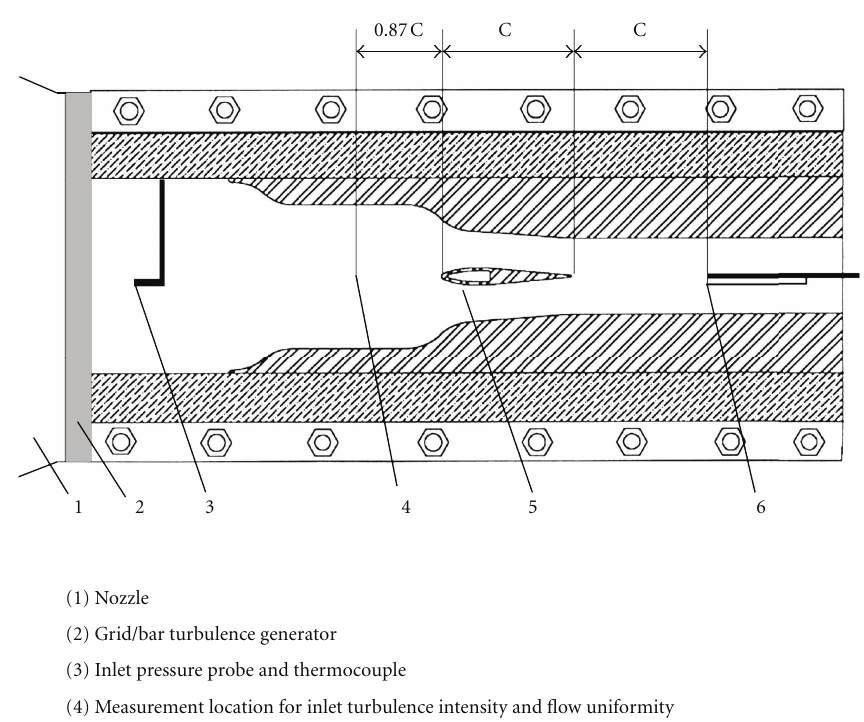
Figure 1: Schematic diagram of the test section employed for the symmetric airfoil investigations